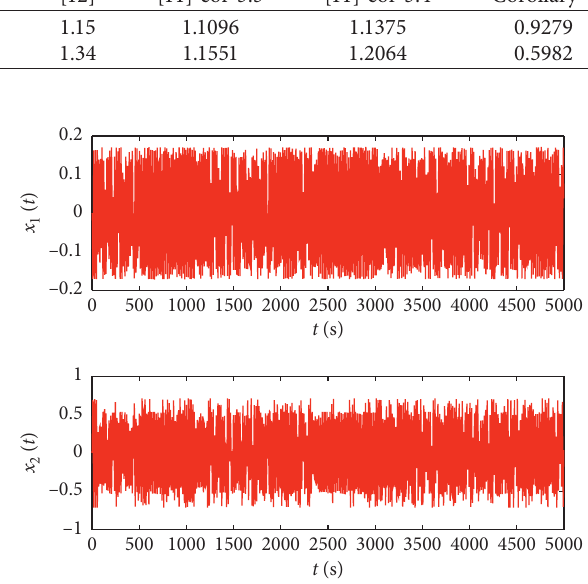
Figure 1: The time responses of state variable x ( t ) of Markov jump system (1) for Case 1.